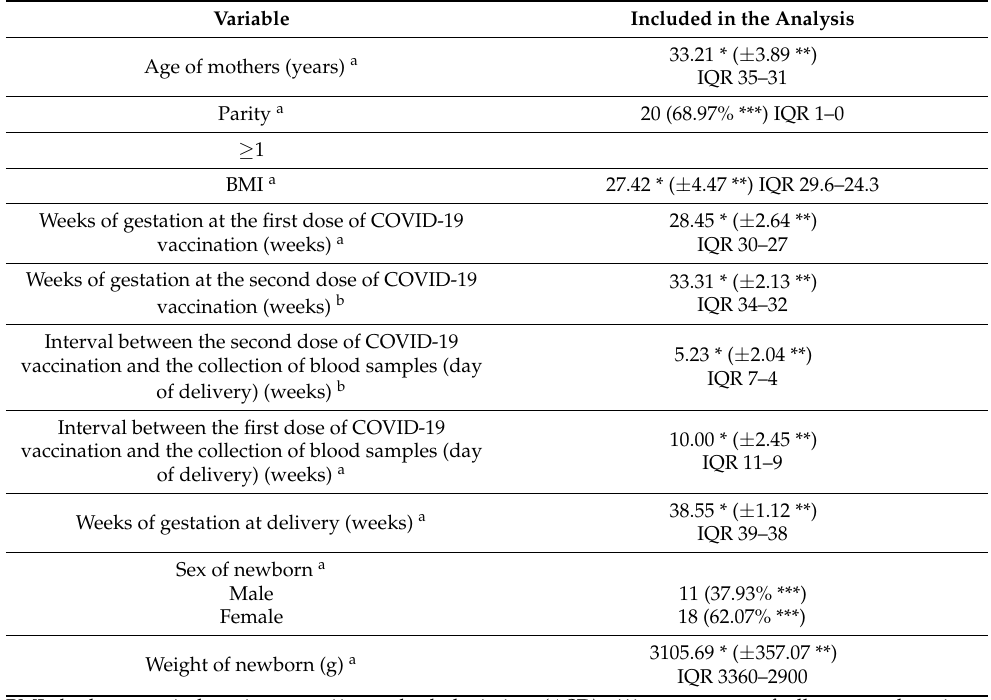
Table 1. Maternal and newborn demographic and clinical